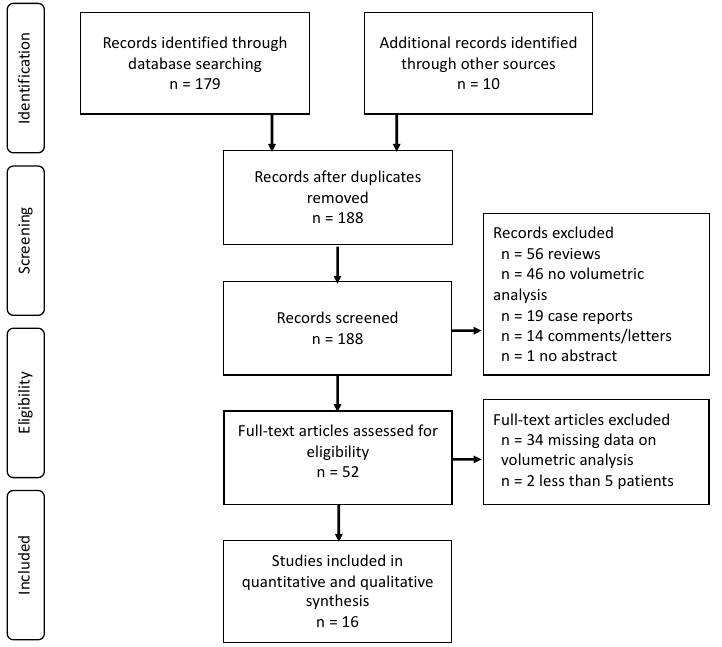
Figure 1. The PRISMA flow chart.